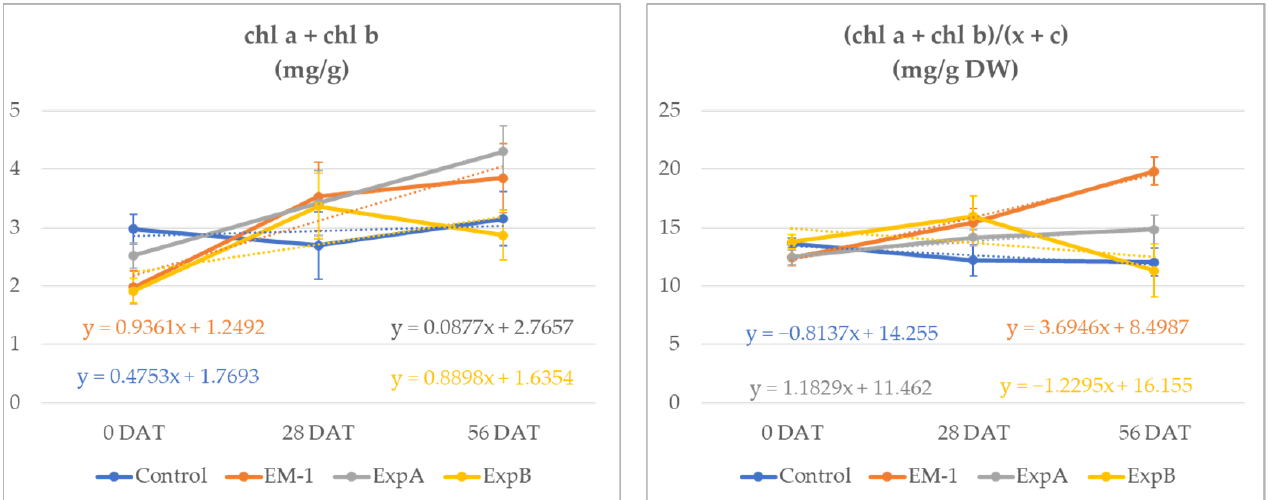
Different letters indicate statistically significant different means for p < 0.05 (*); p < 0.01 (**); ns, not significant.